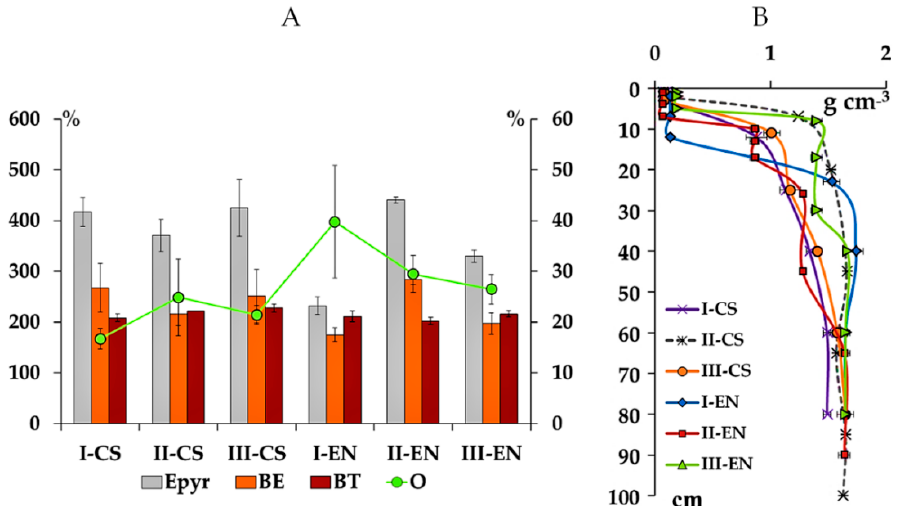
Figure 2. Water contents of organic (( A ) left axis) and mineral (( A ) right axis) horizons and bulk density ( B ) of the studied soils. EN—European North (Komi Republic); CS—Central Siberia (Krasnoyarsk region); I, II, III—site numbers.